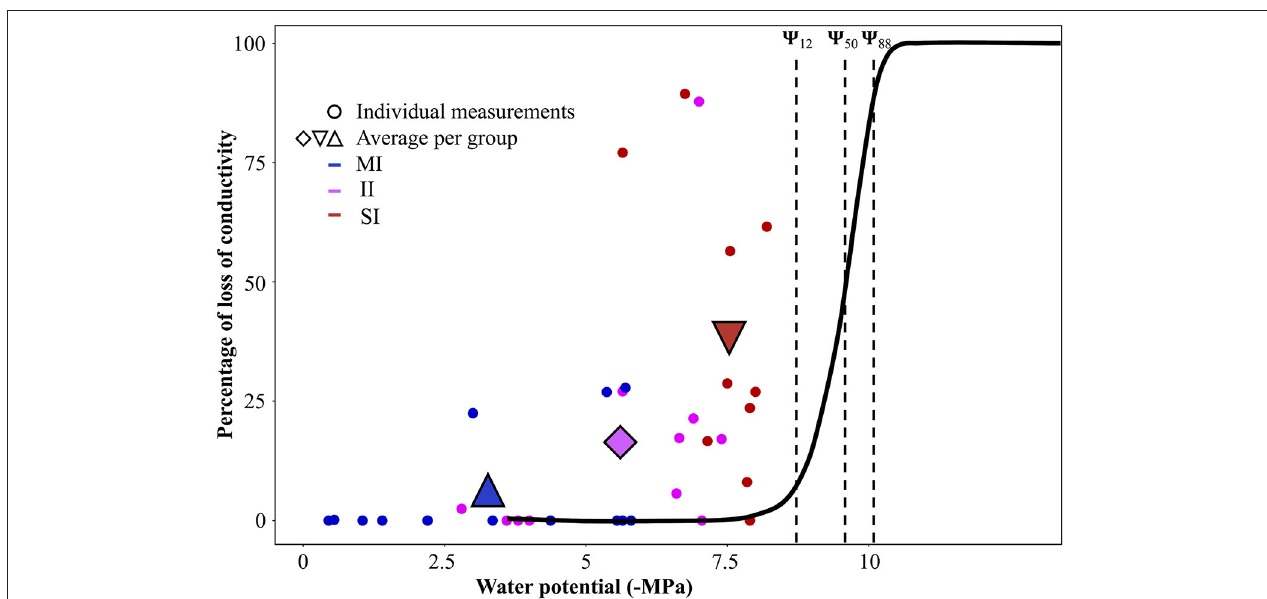
FIGURE 4 | Native embolism measurements with percent loss of conductivity as a function of the water potential in branches sampled at sites of different impact [blue minimal impact (MI), magenta intermediate impact (II), and red severe impact (SI)]. The black sigmoidal curve represents the VC. Points represent an individual measure; triangles and diamonds are the average of these points for each impact class. The dotted lines represent, from left to right, values of 9 12 , 9 50 , 9 88 , extracted from the VC.